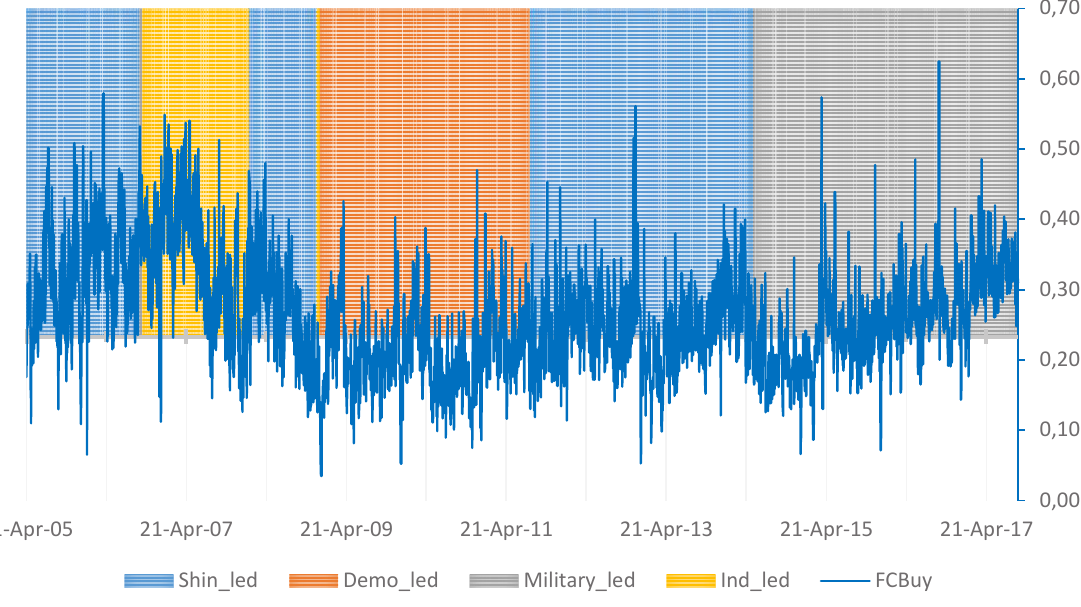
Figure 3. Thai Government and net stock purchase by foreign investors (FCBuy) (April 2005 – April